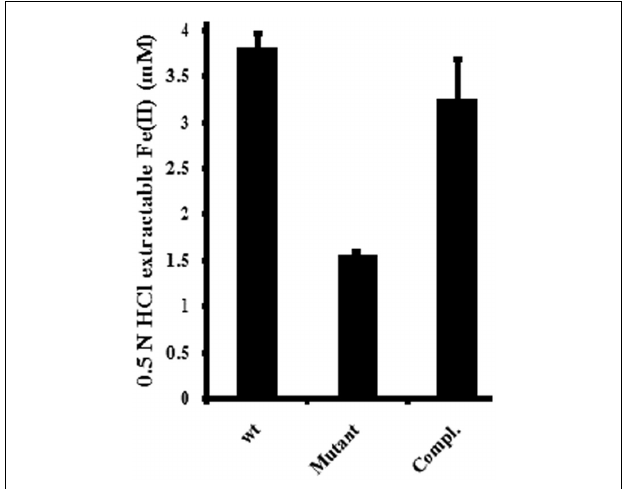
FIGURE 2 | Complementation of Shewanella oneidensis MR-1 mutant without MtrA by MtoA. Fe(II) formation after reduction of 10mM FH by S. oneidensis MR-1 wild type (wt), Δ mtrA mutant with empty vector, and the mutant complemented with MtoA (Compl.) for 240h.The values reported are the means and SD of triplicate measurements.